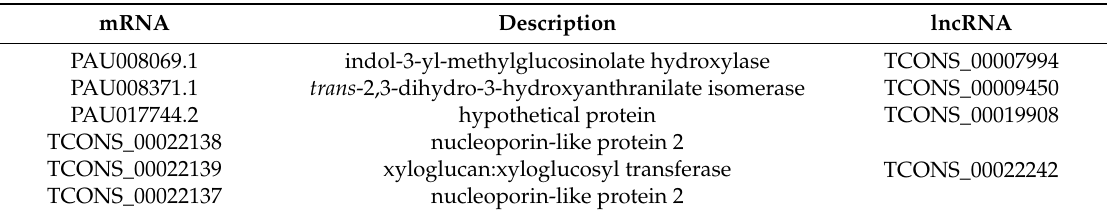
Table 2. Paulownia witches’ broom (PaWB)-related lncRNAs targeting PaWB-related mRNAs.